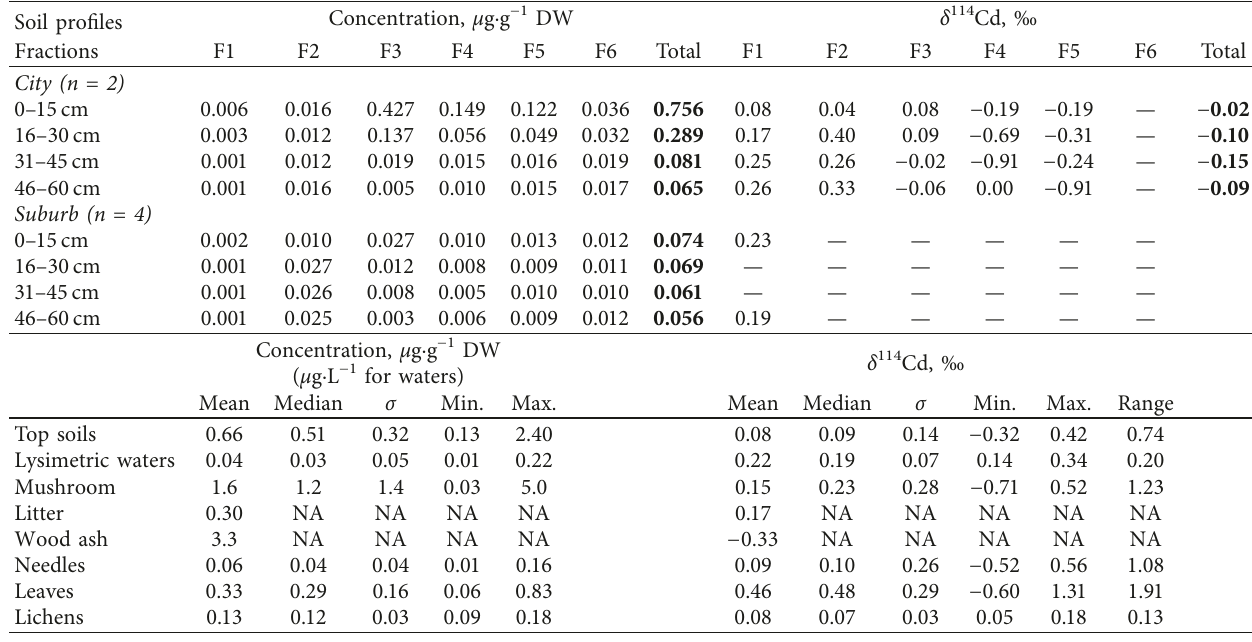
Table 5: Cadmium concentrations and isotopic composition in environmental samples from Lule˚a. Soil